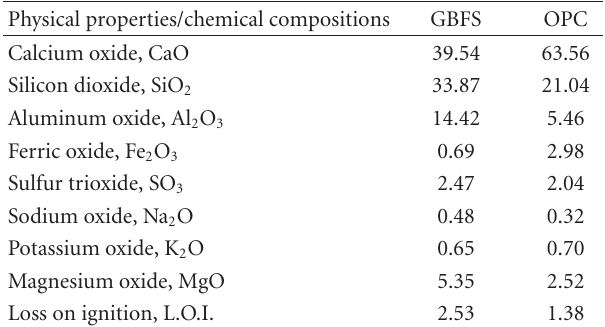
Table 1: Chemical composition of granulated blast furnace slag and cement